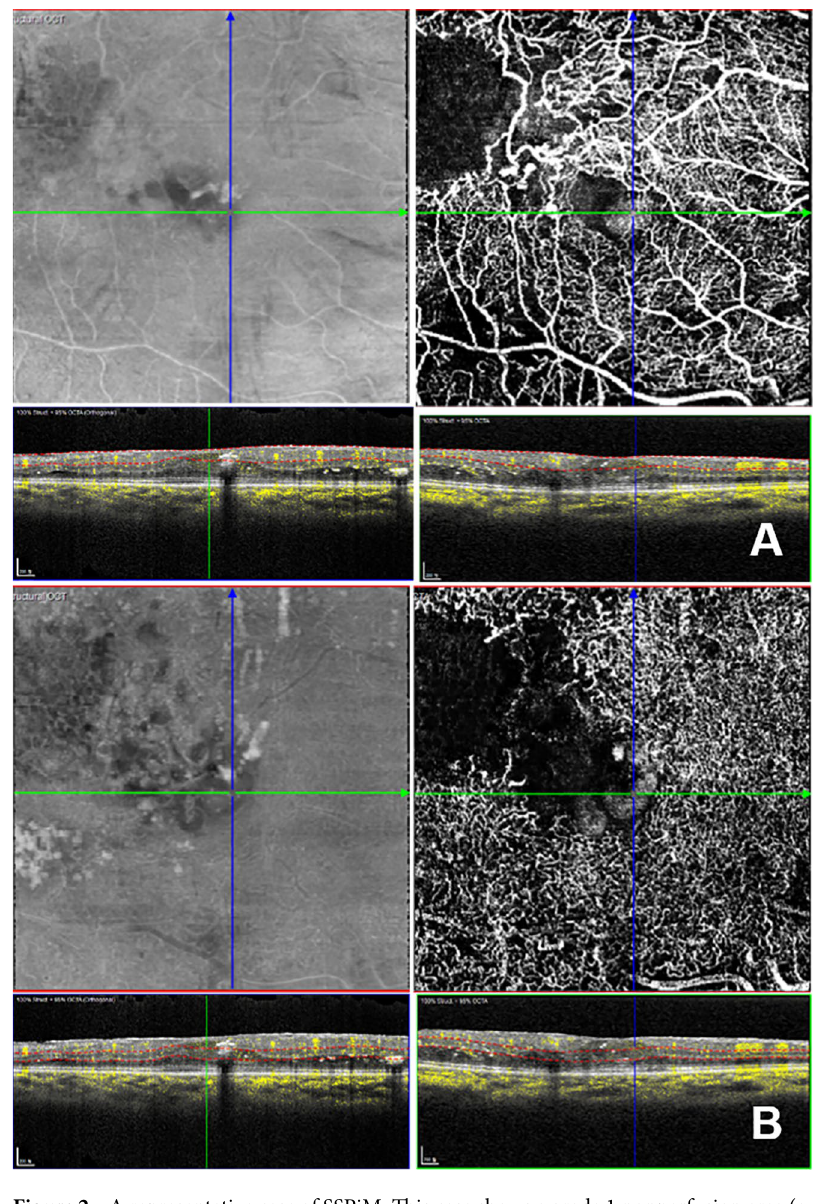
Figure 2. A representative case of SSPiM. This case shows a grade 1 nonperfusion area (axis is about 80 to 90 degree). ( A , B ) Top left is an en face OCT image. Top right is an en face OCTA image. The bottom left is the corresponding vertical B-scan image with flow signal. The bottom right is the corresponding horizontal B-scan image with flow signal. A . SSPiM with flow signal on the fovea was observed in the SVC (top right). ( B ) SSPiM with flow signal on the fovea was also observed in the DVC (top right). ( A , B ) Flow signals were observed in cystoid lesions corresponding to SSPiM (bottom). Photoshop CC 2017 (Adobe Systems Co, San Jose, CA) was used to create this